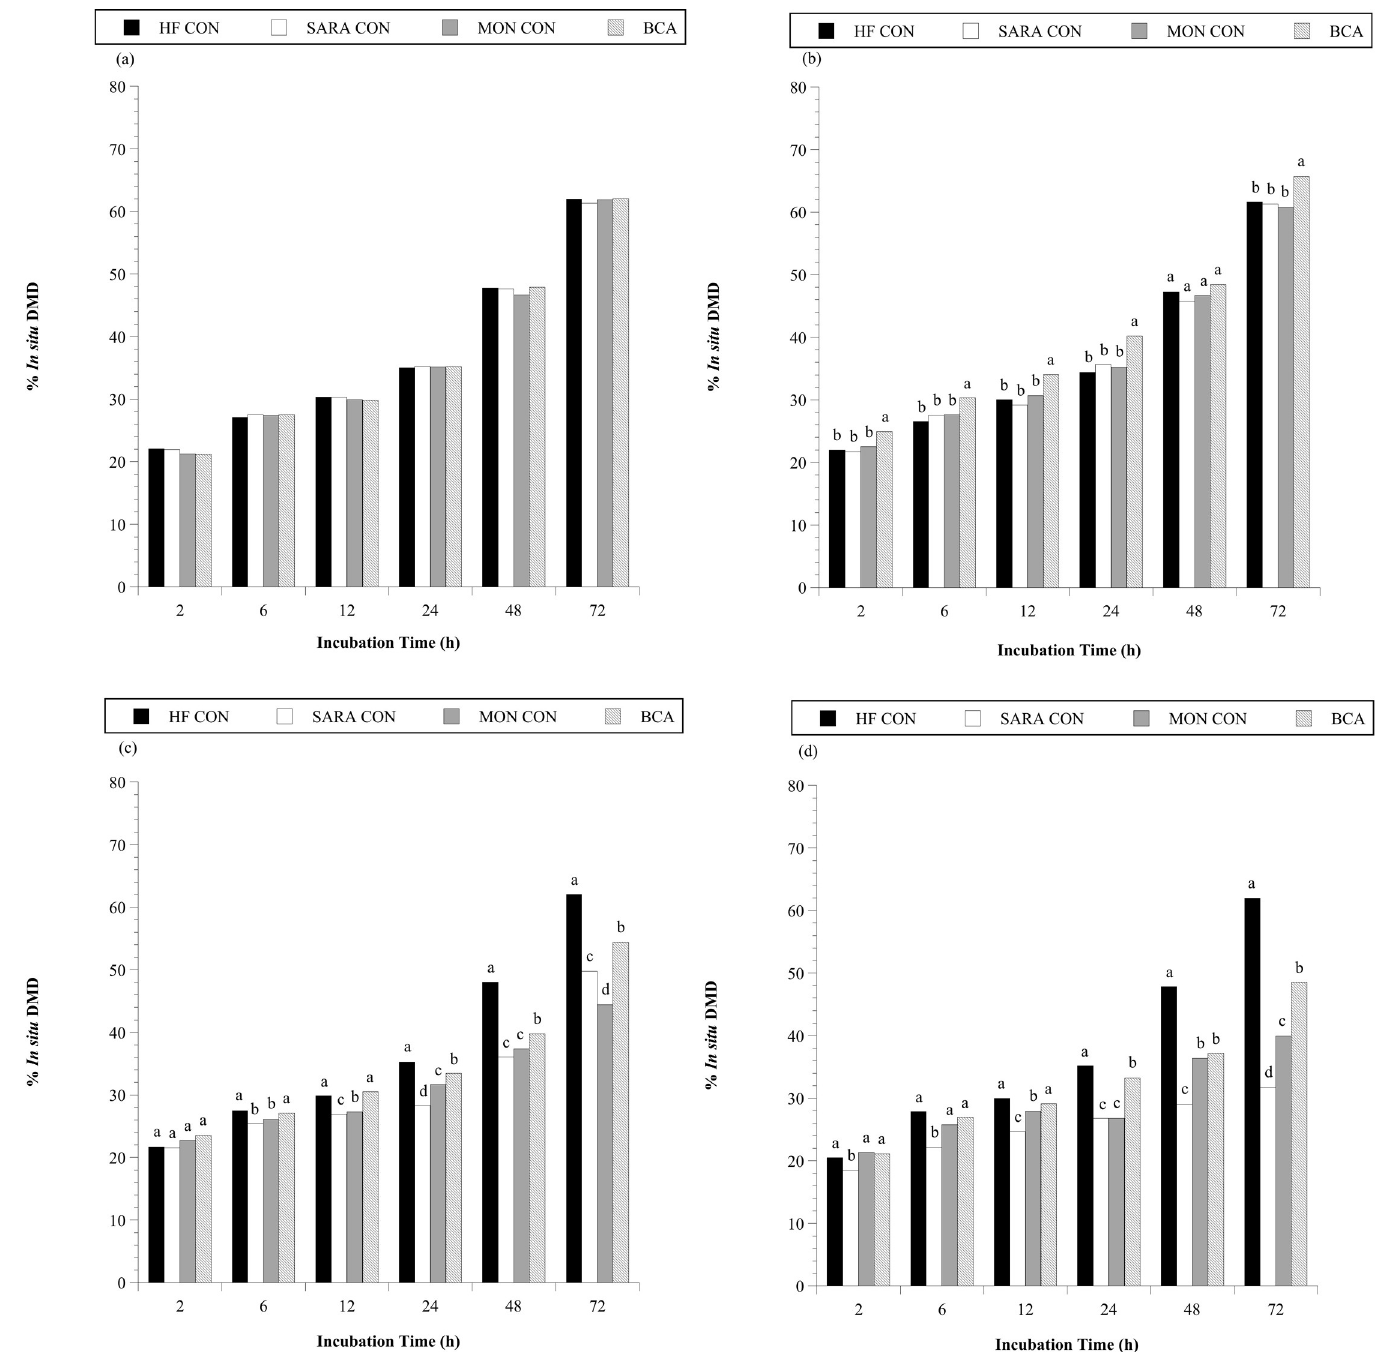
Fig 6. Effect of biochanin A addition on the in situ DM disappearance (% in situ DMD) of ground high quality grass hay in the steer rumen. Holstein steers (n = 12) were blocked by weight into 1 of 4 treatments: High fiber control (HF CON; basal diet control, corn silage + dried distillers’ grain, to meet protein requirements; n = 3), SARA control (SARA CON; n = 3), SARA + monensin treatment (MON CON; 200 mg d -1 monensin; n = 3), or SARA + biochanin A treatment (BCA; 6 g d -1 biochanin A; n = 3). In situ Dacron bags were added at 0, 24, 48, 60, 66, and 70 h of incubation into a weighted mesh bag in the rumen and removed together at 72 h on the last day of the (a) adaptation period (100% basal diet) (b) high fiber period (100% basal diet + treatments), (c) 60:40 SARA challenge period (60% basal diet + 40% cracked corn + treatments, as fed basis), and the (d) 30:70 SARA challenge period (30% basal diet + 70% cracked corn + treatments, as fed basis). Means lacking a common English letter are different within incubation time ( P < 0.05); Treatment: P < 0.0001; Pooled SEM: Treatment = 0.8882.